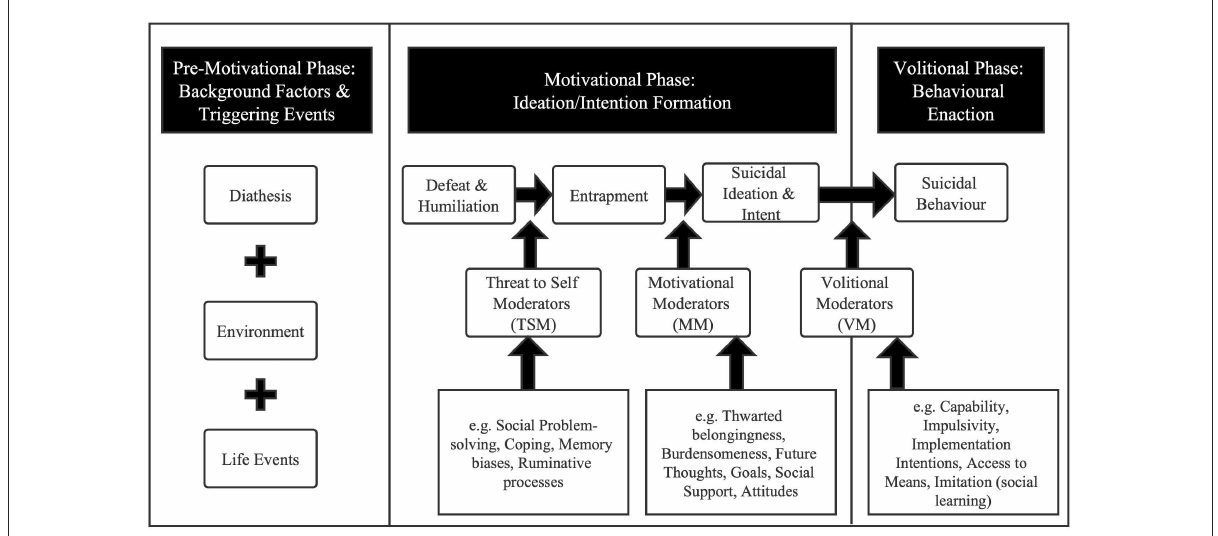
FIGURE1 The IMV model of suicidal behavior (